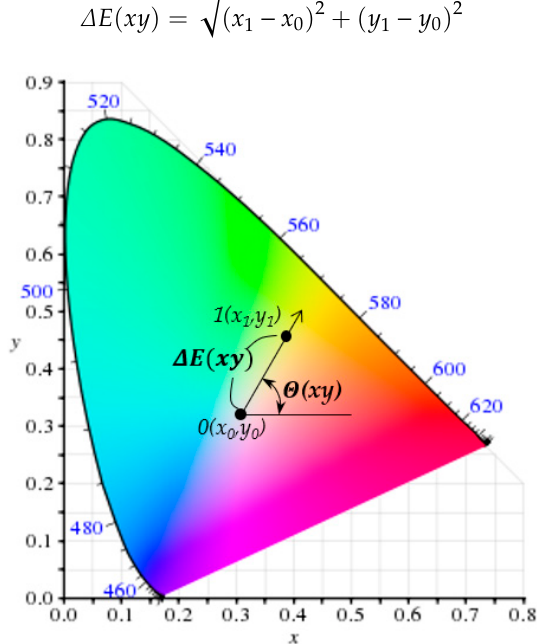
Figure 2. The color space of CIE1931.